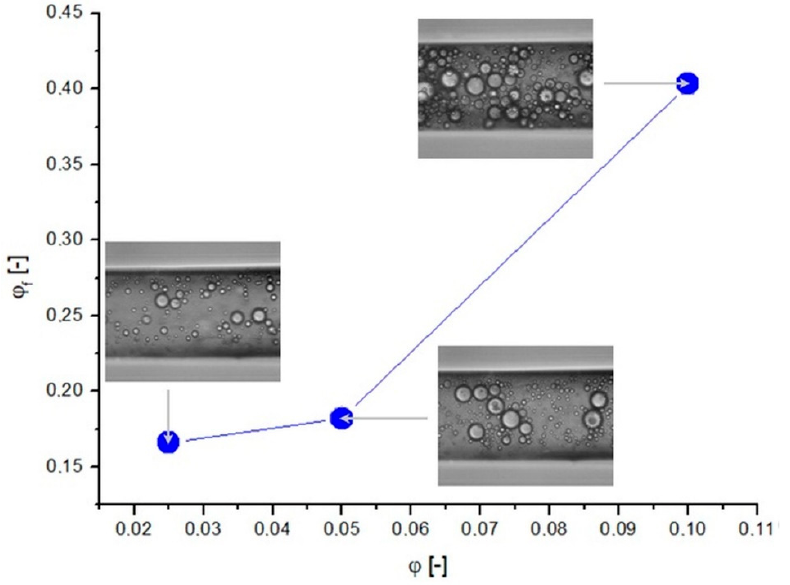
Figure 5. Dependence of the degree of compaction on the initial concentration of emulsion at a liquid flow rate of 10 μ L/h.